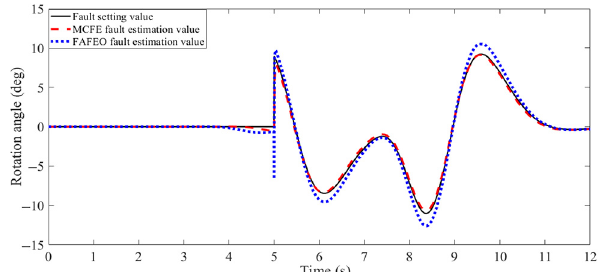
Figure 20 Fault estimation curve of the rotation angle sensor